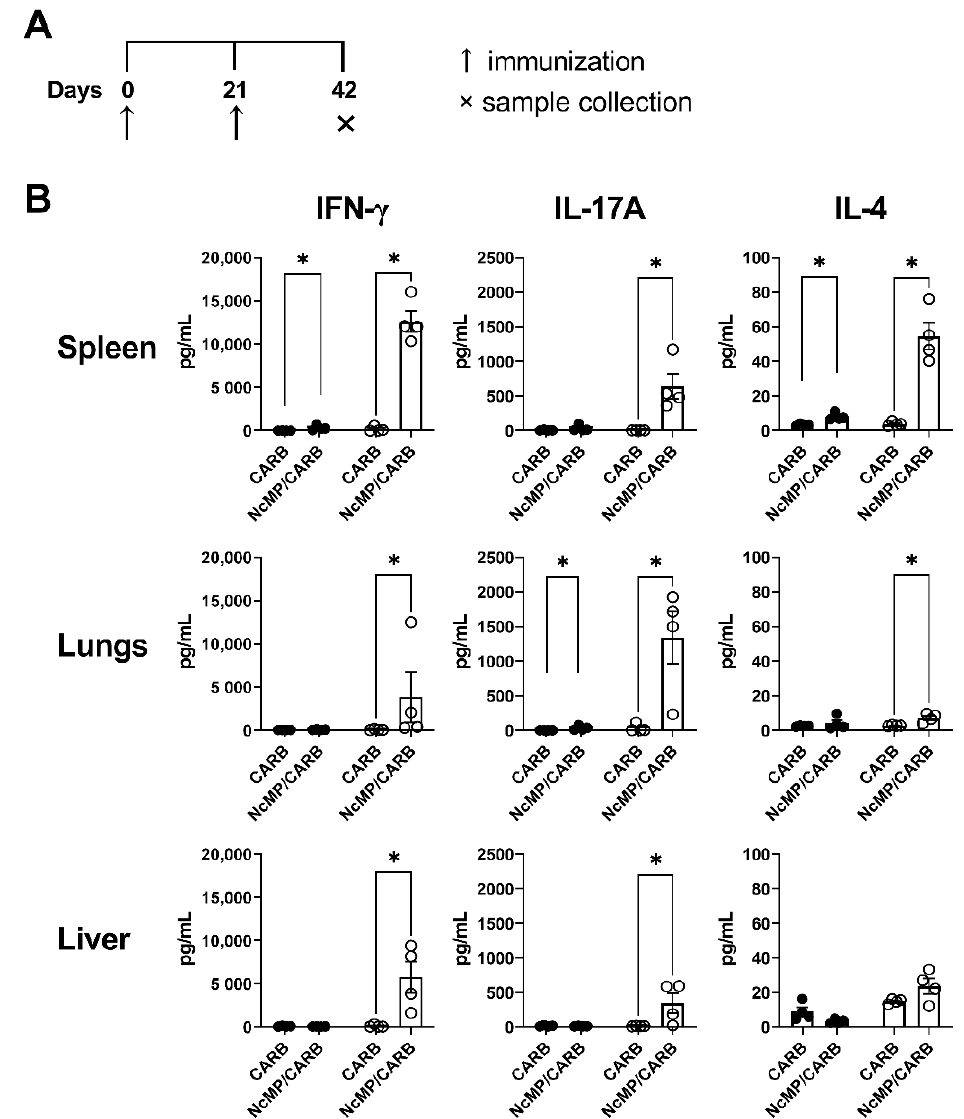
Figure 2. Analysis of cytokine production. Timeline of immunization and sample collection ( A ). IFN- γ , IL-17A and IL-4 concentration ( B ) in the supernatants of leukocyte cell cultures unstimulated (closed circles) or stimulated (open circles) for 3 days with N. caninum whole parasite antigen sonicates. Cells were isolated from the spleen, lungs and liver of mice from NcMP/CARB or control CARB groups, as indicated, 21 days after the boost immunization. Each symbol represents an individual mouse; bars correspond to the mean value in each group ± SEM. Results are from one representative experiment out of two independent experiments that yielded concordant results. ( n = 4 group; * p < 0.05, Mann– Whitney.)